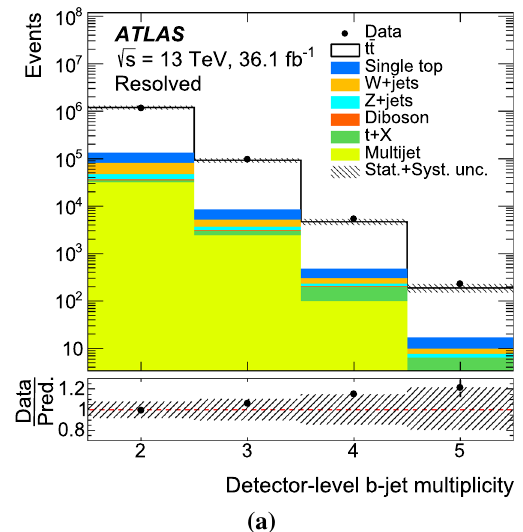
Fig. 2 Kinematic distributions in the (cid:3) + jets channel in the resolved topology at detector-level: a number of b -tagged jets and b b -tagged jet pseudorapidity. Data distributions are compared with predictions using Powheg + Pythia8 as the t ¯ t signal model. The hatched area rep- resents the combined statistical and systematic uncertainties (described